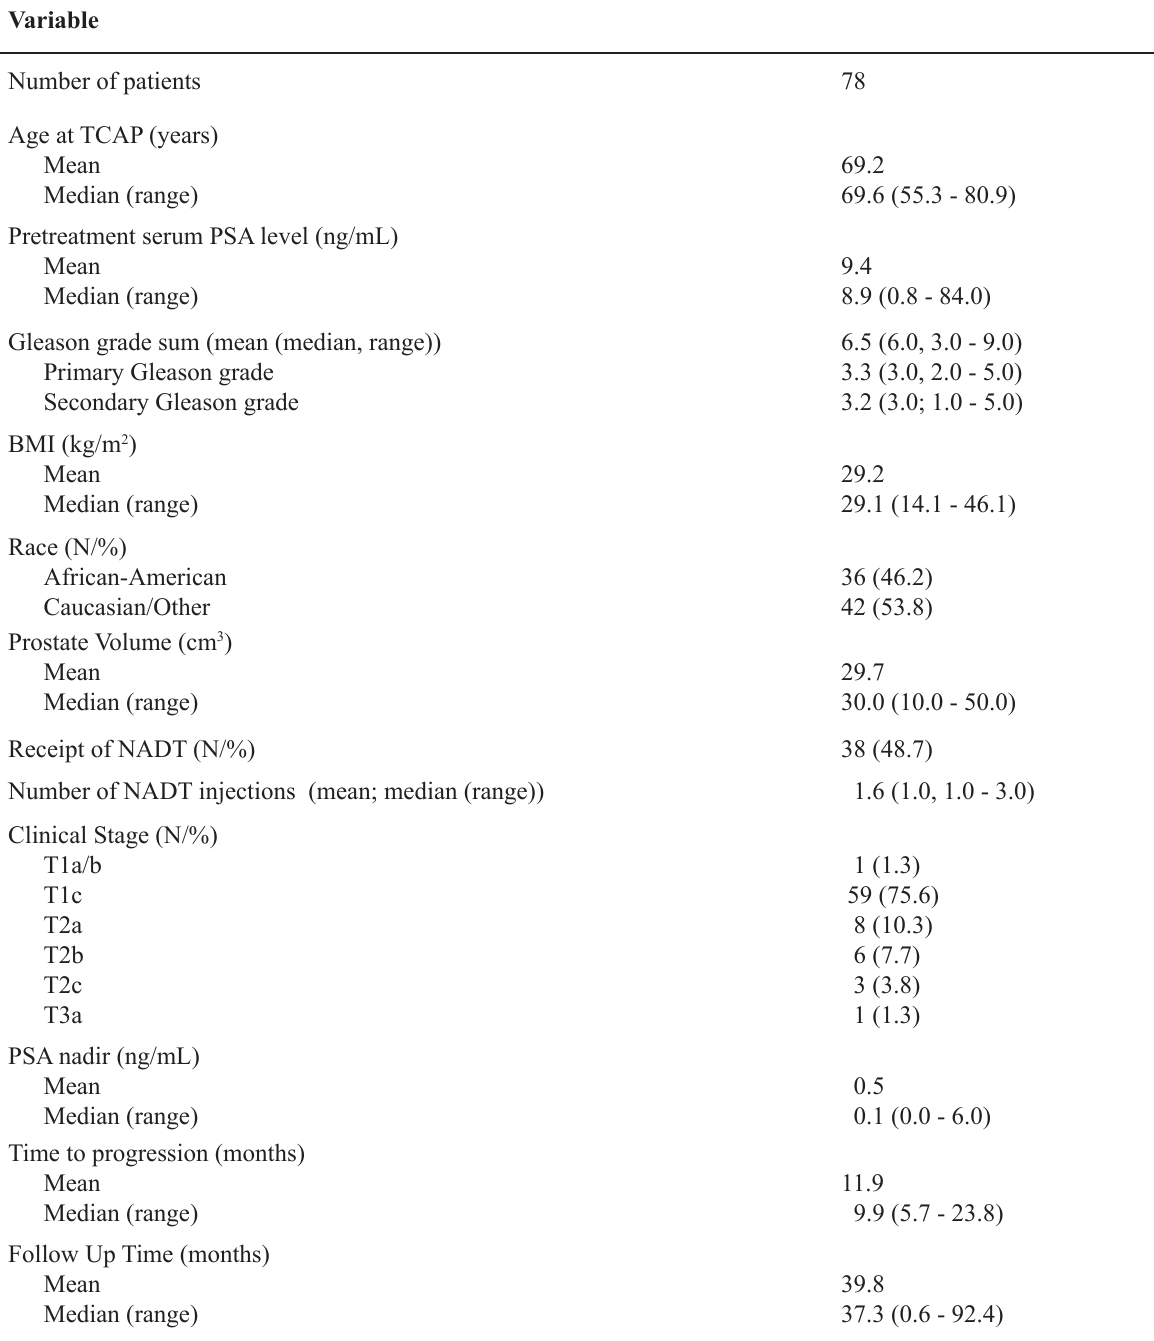
Table 1 – Demographic and clinicopathologic data on 78 men undergoing primary targeted cryoablation of the prostate (TCAP) for clinically localized prostate